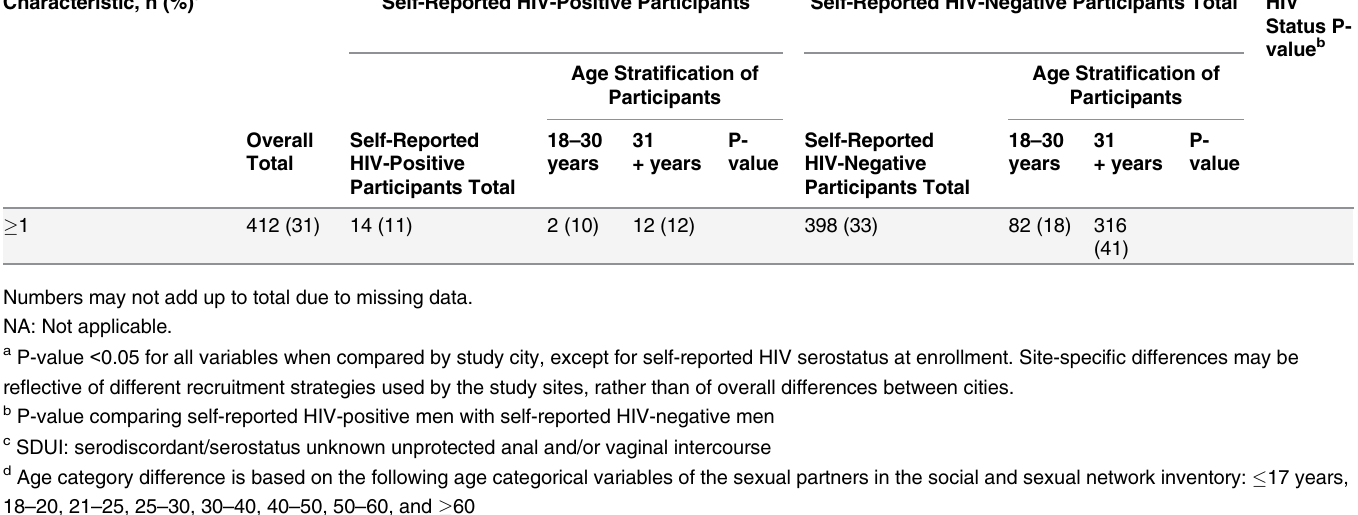
Multivariate models for each outcome stratified by self-reported HIV status are presented in Table 3. The odds of having a Black partner among HIV-positive men were higher with not identifying as Latino/Hispanic, while lower for having a non-primary partner. Among HIV- negative men, the odds of having a Black partner were higher with age (cid:1) 20 years vs. > 40 years, self-identifying as bisexual vs. homosexual/gay, not identifying as Latino/Hispanic, and having less than college degree. The odds were lower for men aged between 21 – 40 years vs. > 40 years, those having an anonymous/exchange or trade partner vs. primary partner, and those having a sexual network density of 50 – 100% vs.